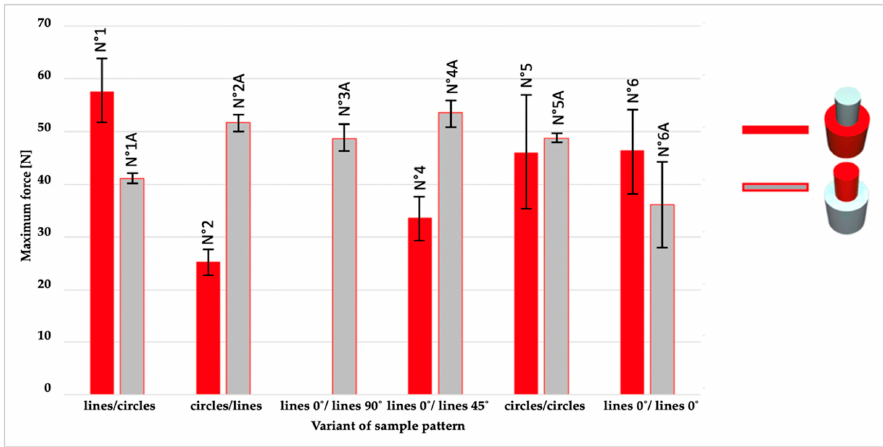
Figure 7. An overview of maximum force for 11 series of samples (different configuration of patterns and material sequence).